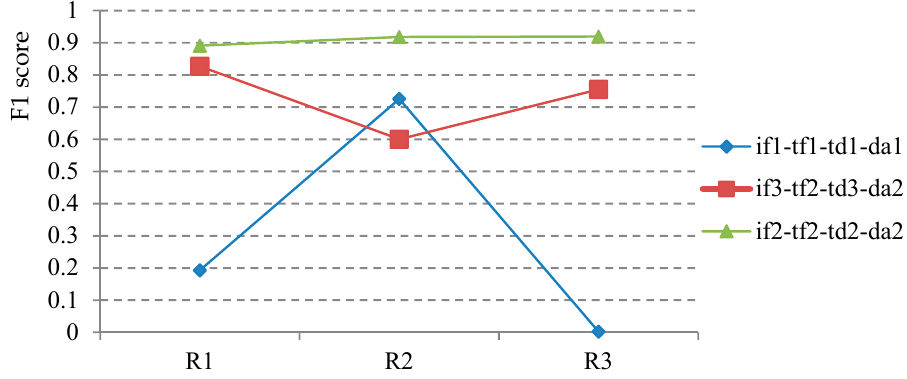
Figure 18. Average F1 scores on 10 test data for 9 trained models in the last row of Table 2.